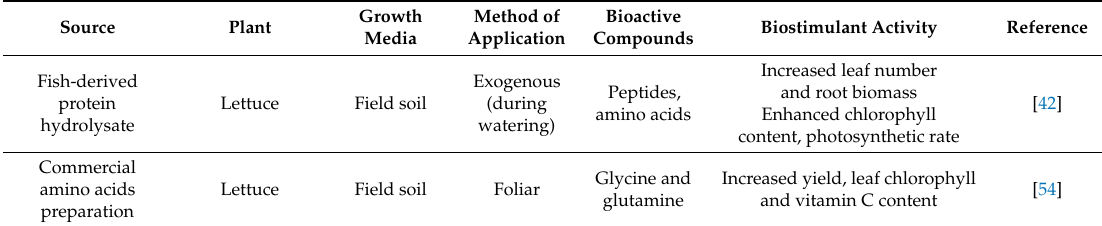
Table 2. Examples of protein hydrolysates from di ff erent fish and animal sources and their application as plant